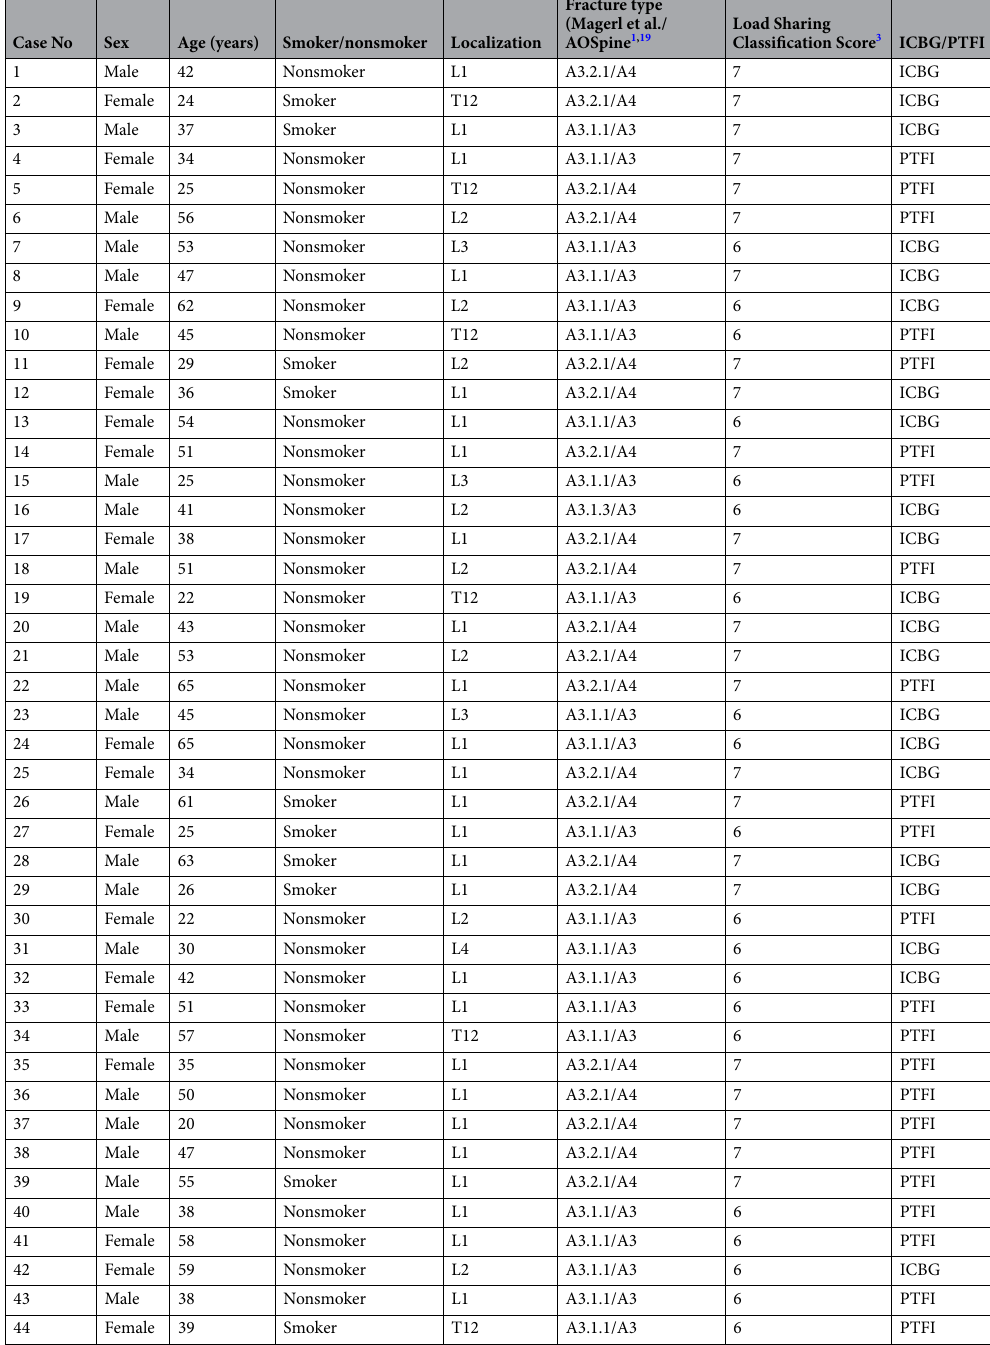
Table 2. Patient demographics. Iliac crest bone graft (ICBG), porous tantalum fusion implant